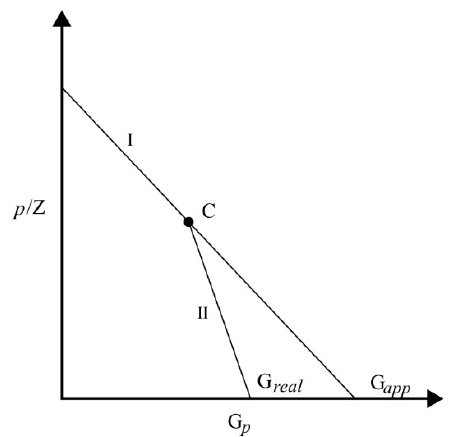
Figure 1. The relationship between p / Z and cumulative gas production volume of the abnormally high-pressured reservoirs.